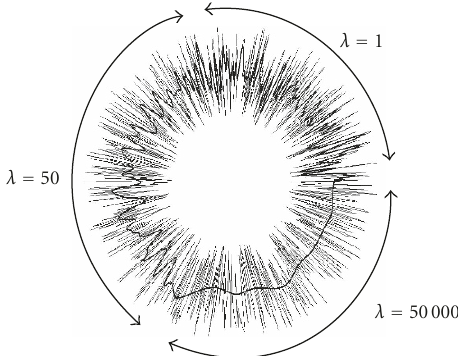
Figure 8: Spatially variant smoothing-spline filtering. The input signal is the noisy circle. This signal is filtered through a smoothing- spline filter where the smoothing parameter λ varies along the con- tour. The resulting signal is represented in